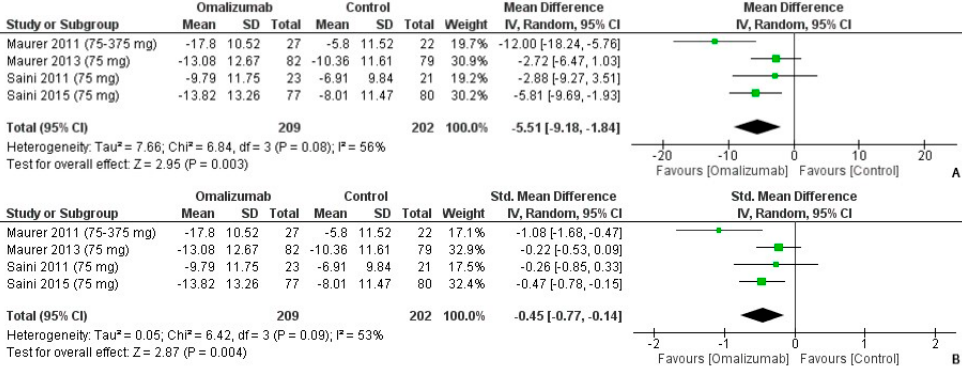
Figure 8. UAS7 outcomes with 75 mg dosage of omalizumab [17 − 19,23]. ( A ): Mean difference: − 5.51 [95% CI: − 9.18, − 1.84]; Heterogeneity: Tau² = 7.66; Chi² = 6.84, df = 3 ( p = 0.08); I² = 56%; Test for overall effect: Z = 2.95 ( p = 0.003). ( B ): Standardized mean difference: − 0.45 [95% CI: − 0.77, − 0.14]; Heterogeneity: Tau² = 0.05; Chi² = 6.42, df = 3 ( p = 0.09); I² = 53%; Test for overall effect: Z = 2.87 ( p = 0.004).